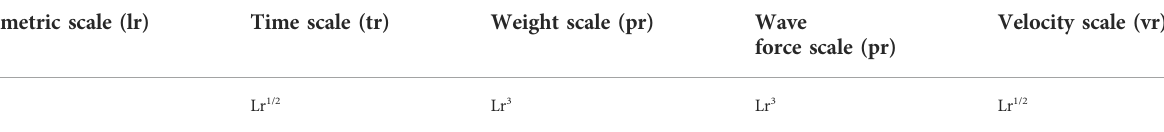
TABLE 2 Model scale.